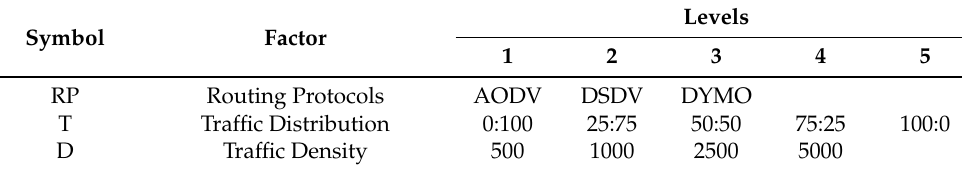
Table 9. Factors and their respective levels for